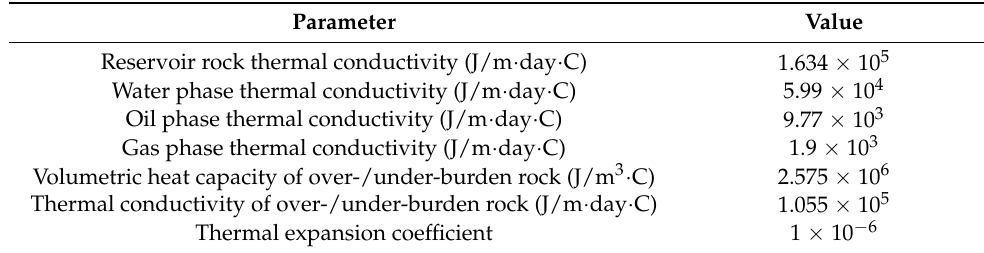
Table 2. The key thermal reservoir